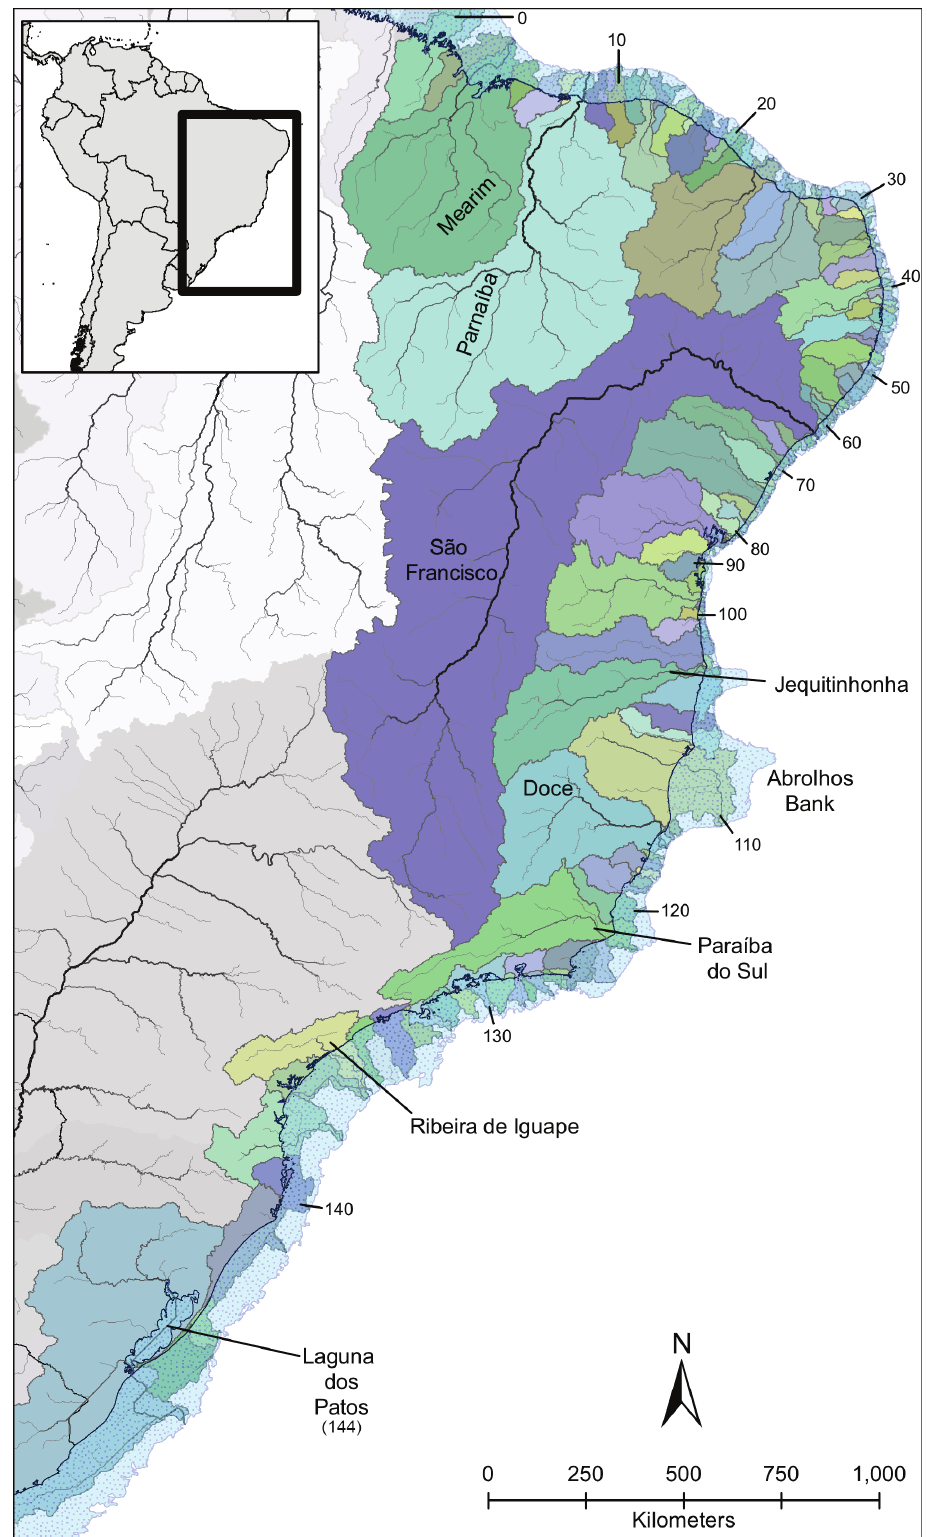
Fig. 3. Map of the 145 palaeodrainages inferred for a sea level retreat of -125 m during glacial periods of the Pleistocene; the black line marks the current coastline of Brazil. Both the area that includes the contemporary exposed land area, as well as the area of the continental shelf exposed when sea levels dropped (marked with stippling) is shown for each paleodrainage, with each paleodrainage shown in a different colour. Numbers along the coast indicate the paleodrainage ID on Tab.